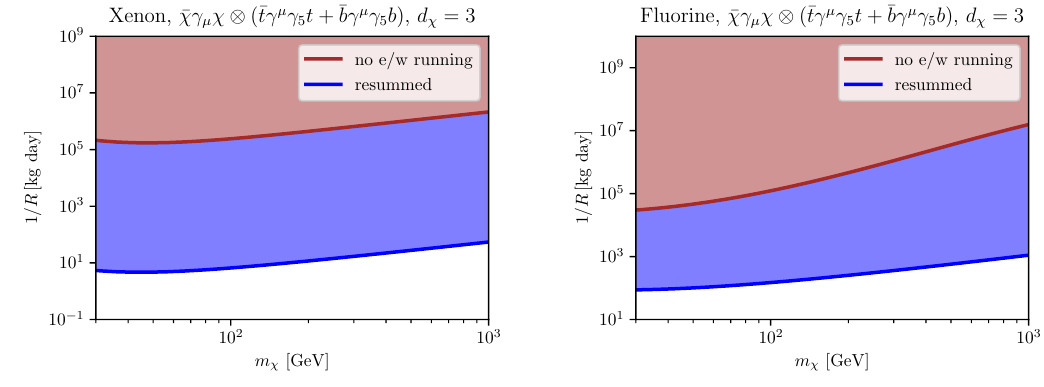
Figure 16 . Same as (cid:12)gure 14, but for I (cid:31) = 1 ; Y (cid:31) = 0 Dirac fermion DM with